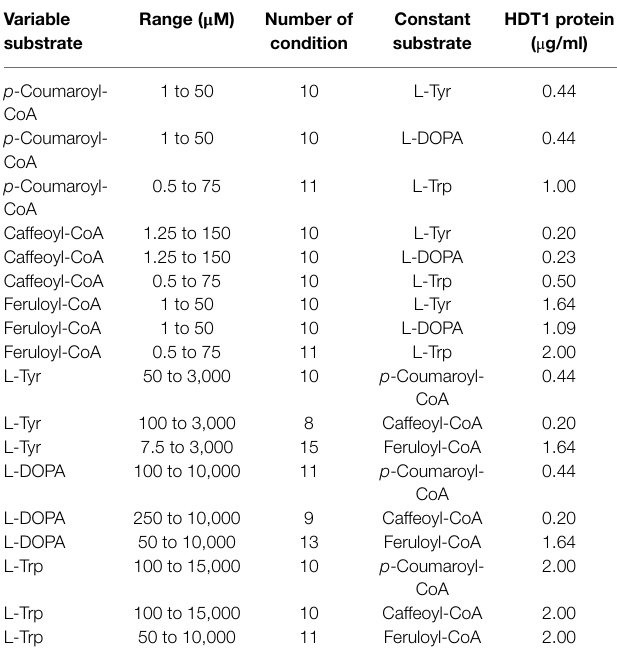
TABLE 2 | Reaction conditions for determination of kinetic